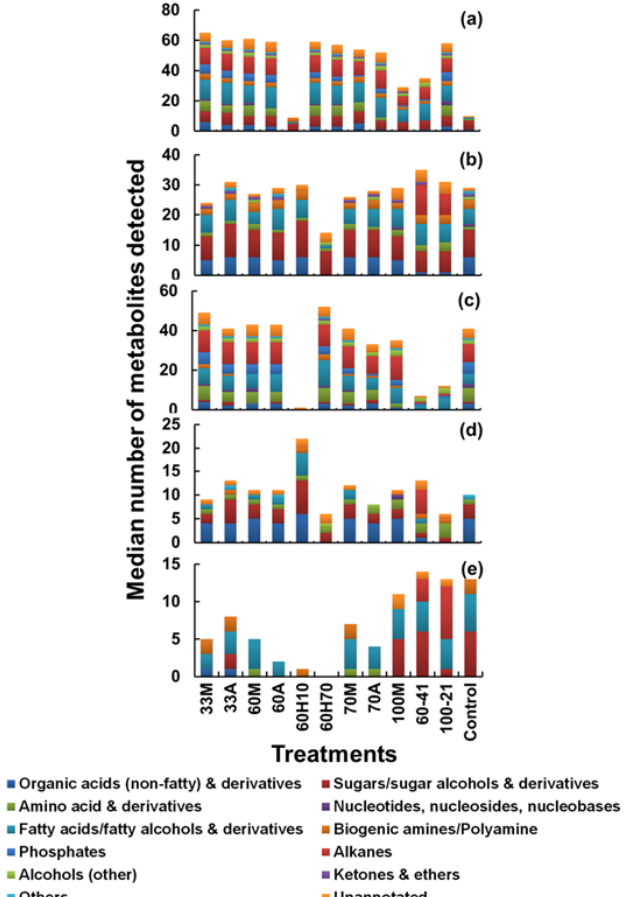
Figure 3. A summary of the unique recovery efficiency of all the nine quenching treatments involved in Approach 1 and 3. The X-axis represents different sampling treatments: 33M = 33% methanol; 33A = 33% methanol + ammonium bicarbonate (AMBIC); 60M = 60% methanol; 60A = 60% methanol + AMBIC; 60H10 = 60% methanol + 10 mM 4-(2-hydroxyethyl)-1-piperazineethanesulfonic acid